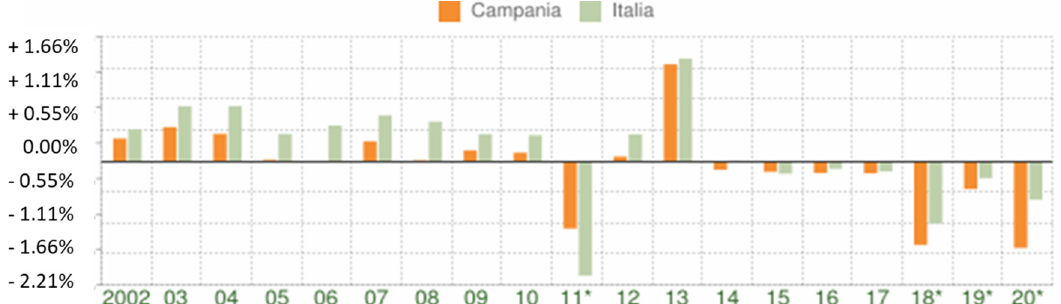
Figure 4. Comparison in percentage terms between the Campania region and Italy of the variation in population years 2002–2020 (source ISTAT, elaboration TUTTITALIA.IT).